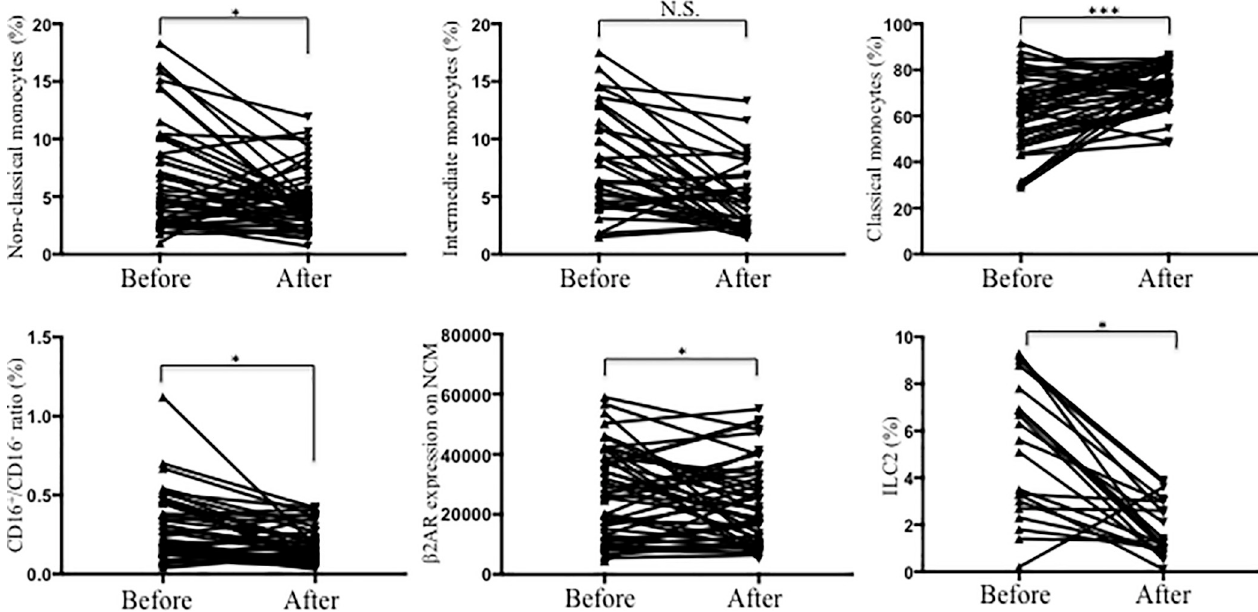
Fig 5. Changes in Mo subsets, circulating ILC2s and β 2AR expression after diet. Graphs of symbols & lines from obese subjects are shown before and after intervention for a-d) Percentage of Mo subsets, e) β 2AR expression on IM, and f) percentage of ILC2s. � p < 0.05, �� p < 0.01, ��� p < 0.001.